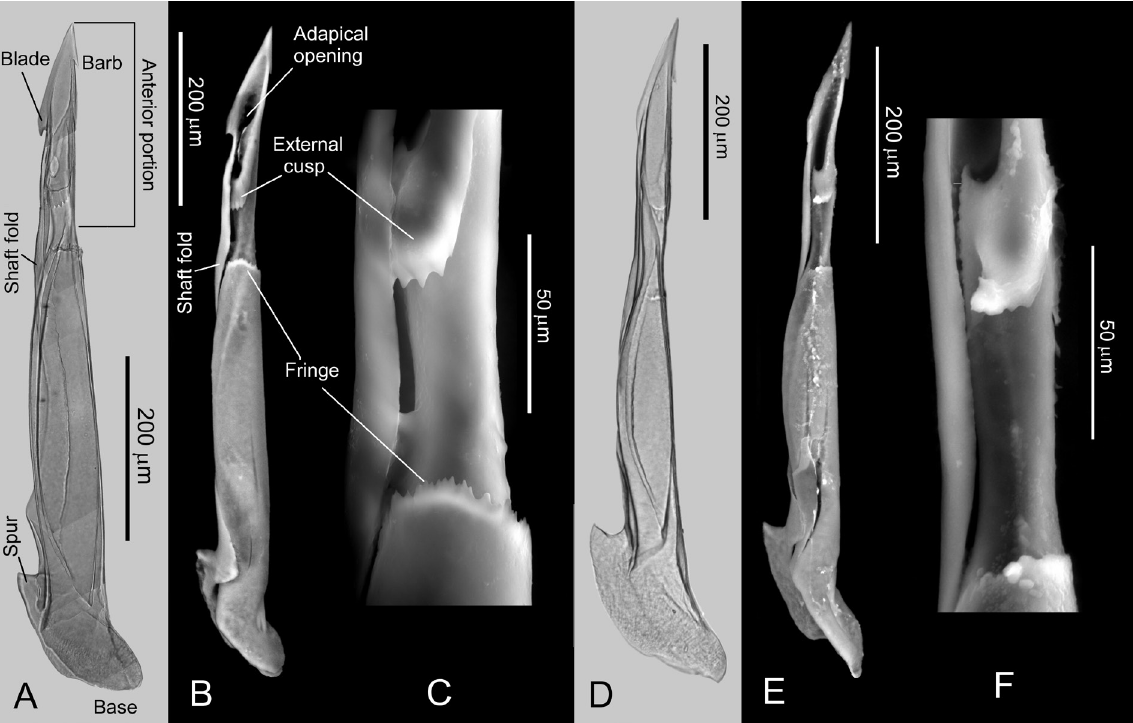
Fig. 2. — A–C . Radular teeth extracted from Profundiconus vaubani (Röckel & Moolenbeek, 1995), with major parts and structures labelled. A . Optical photograph (MNHN, uncataloged, S B . SEM photograph (MNHN, uncataloged, S 26.0 mm). C . Enlargement of the middle section of B. — L D–F . Radular teeth extracted from Profundiconus teramachii (Kuroda, 1956). D . Optical photograph (MNHN IM-2013-44602, S 82.7 mm). E . SEM photograph (MNHN IM-2013-50257, S L